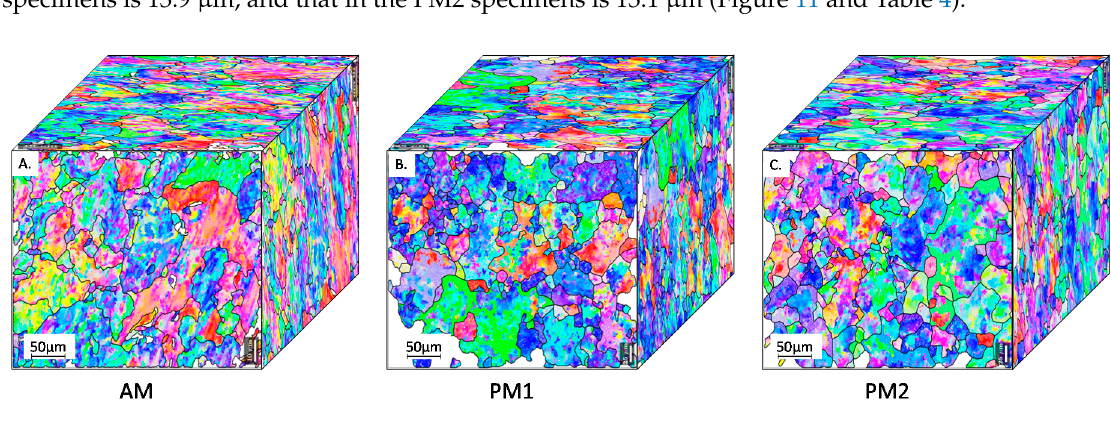
Figure 10. XRD diffractograms of the AM and PM specimens.